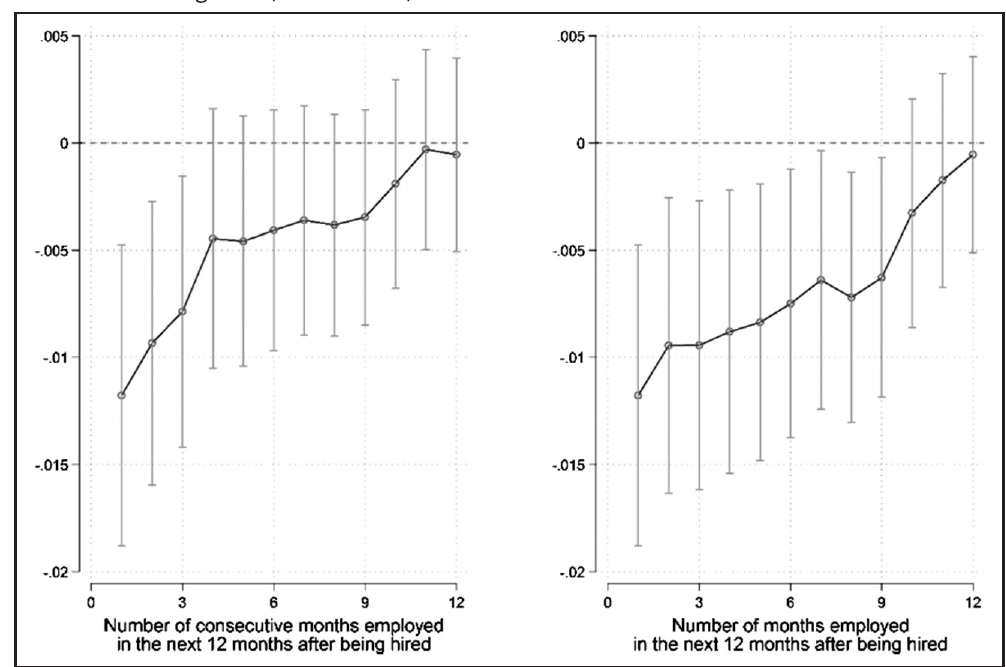
The effect of abolition of the subsidy on the probability of finding employment lasting 1–12 (consecutive)